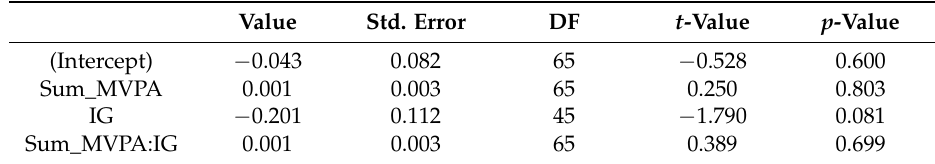
Table A6. Interaction of physical activity on cortisol (whole